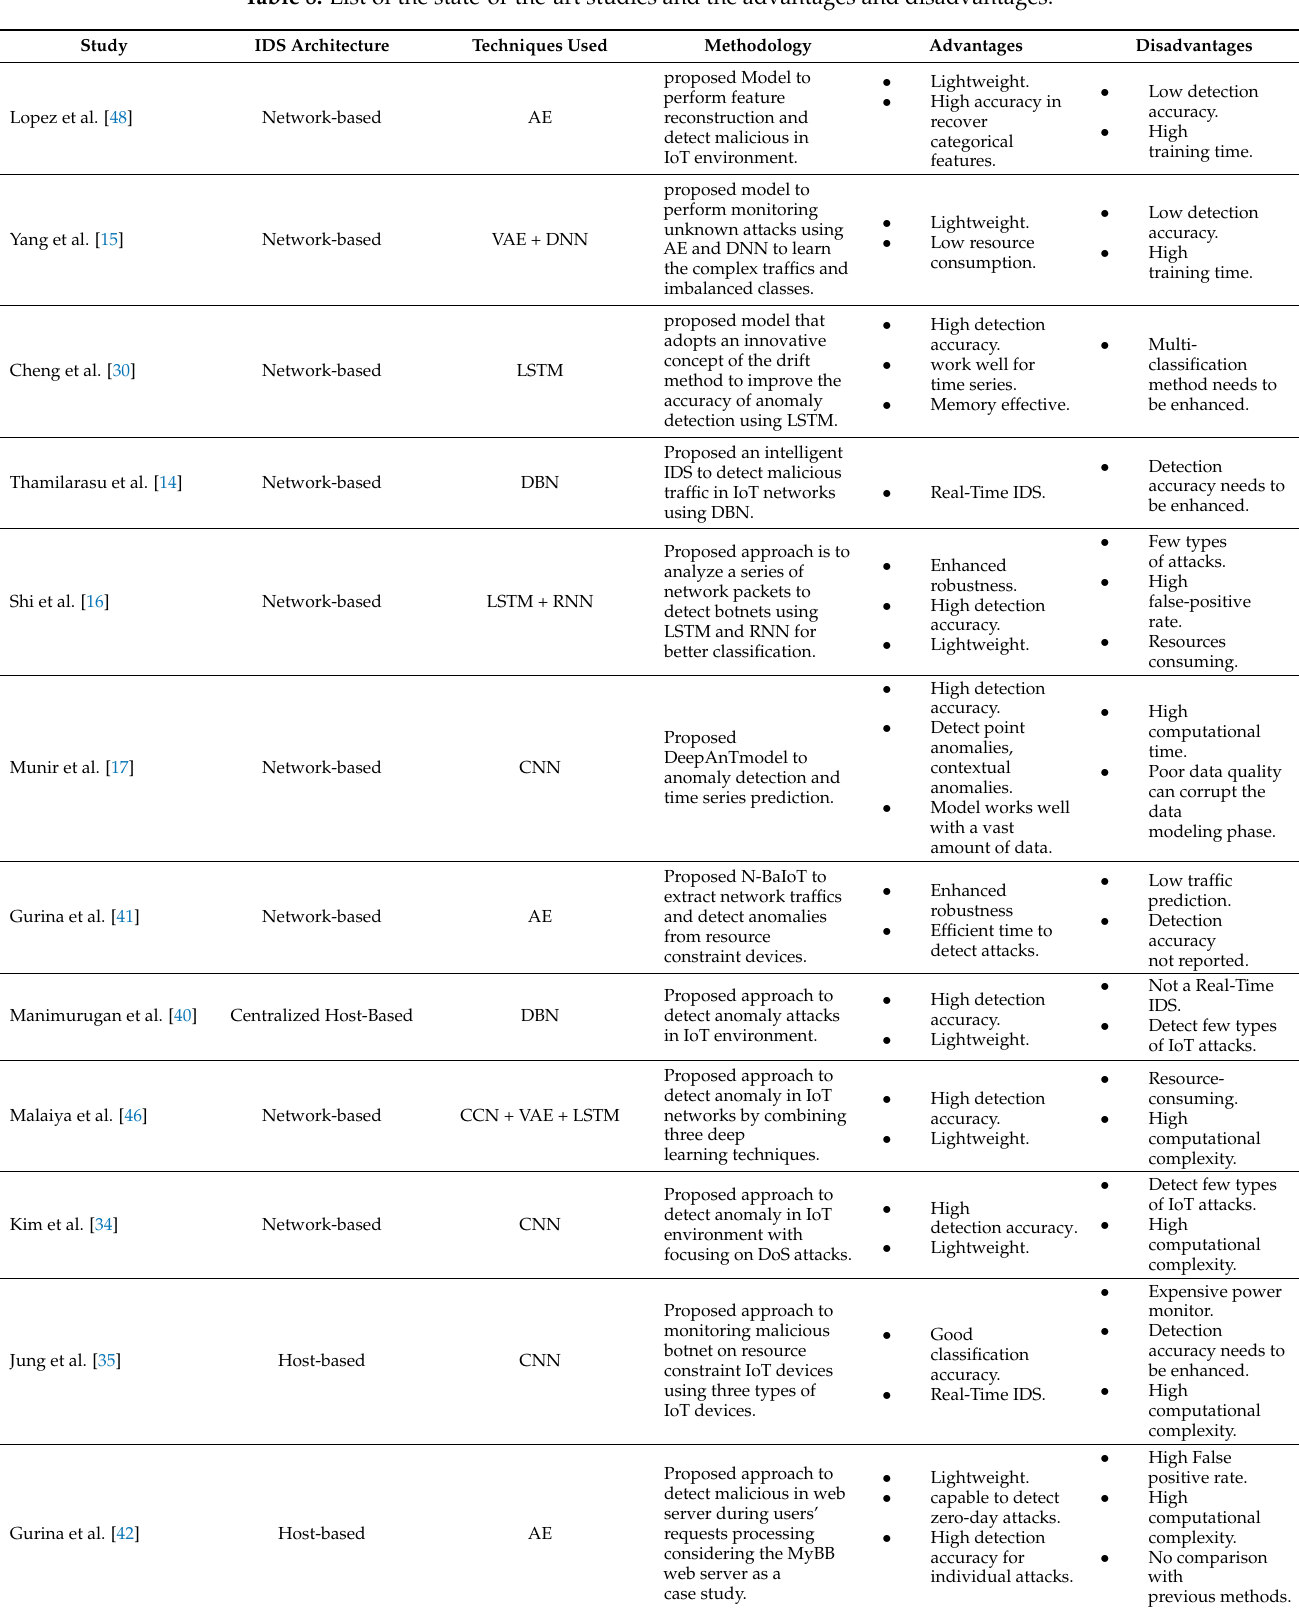
Table 8. List of the state-of-the-art studies and the advantages and